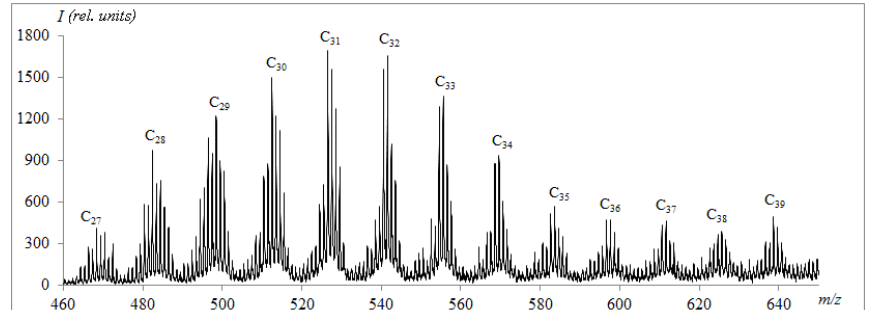
Figure 5. MALDI-TOF mass spectrum of pVP from DMF extract of the resins of HO no. 1.